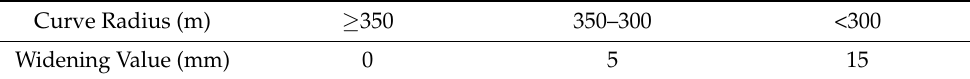
Table 11. Gage widening values in Chinese railways (1983) (mm).